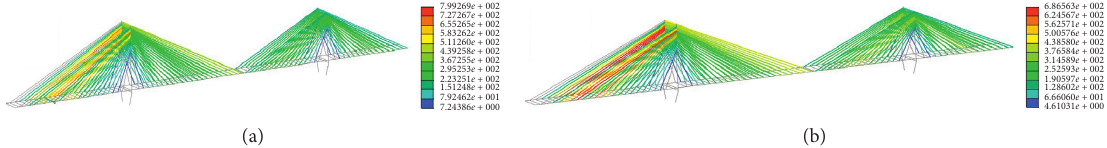
Figure 22: Cable force distributions for the repair cases (unit: tonf): (a) repair scheme 1 and (b) repair scheme 2.